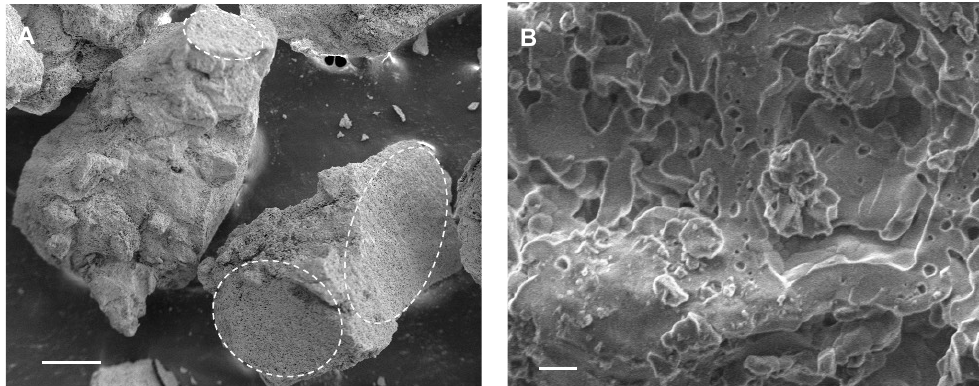
Figure 1. Scanning electron microscope microphotographs of MgSrHA granules. The surface displays a high degree of roughness, with numerous cavities, because of the sintering process. Most cavities are a few microns wide, though smaller pores are present. ( A ) Bar = 200 μ m. ( B ) Bar = 2 μ m.